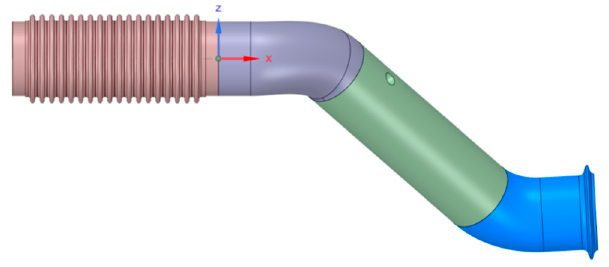
Figure 4. The separated exhaust cell zone.